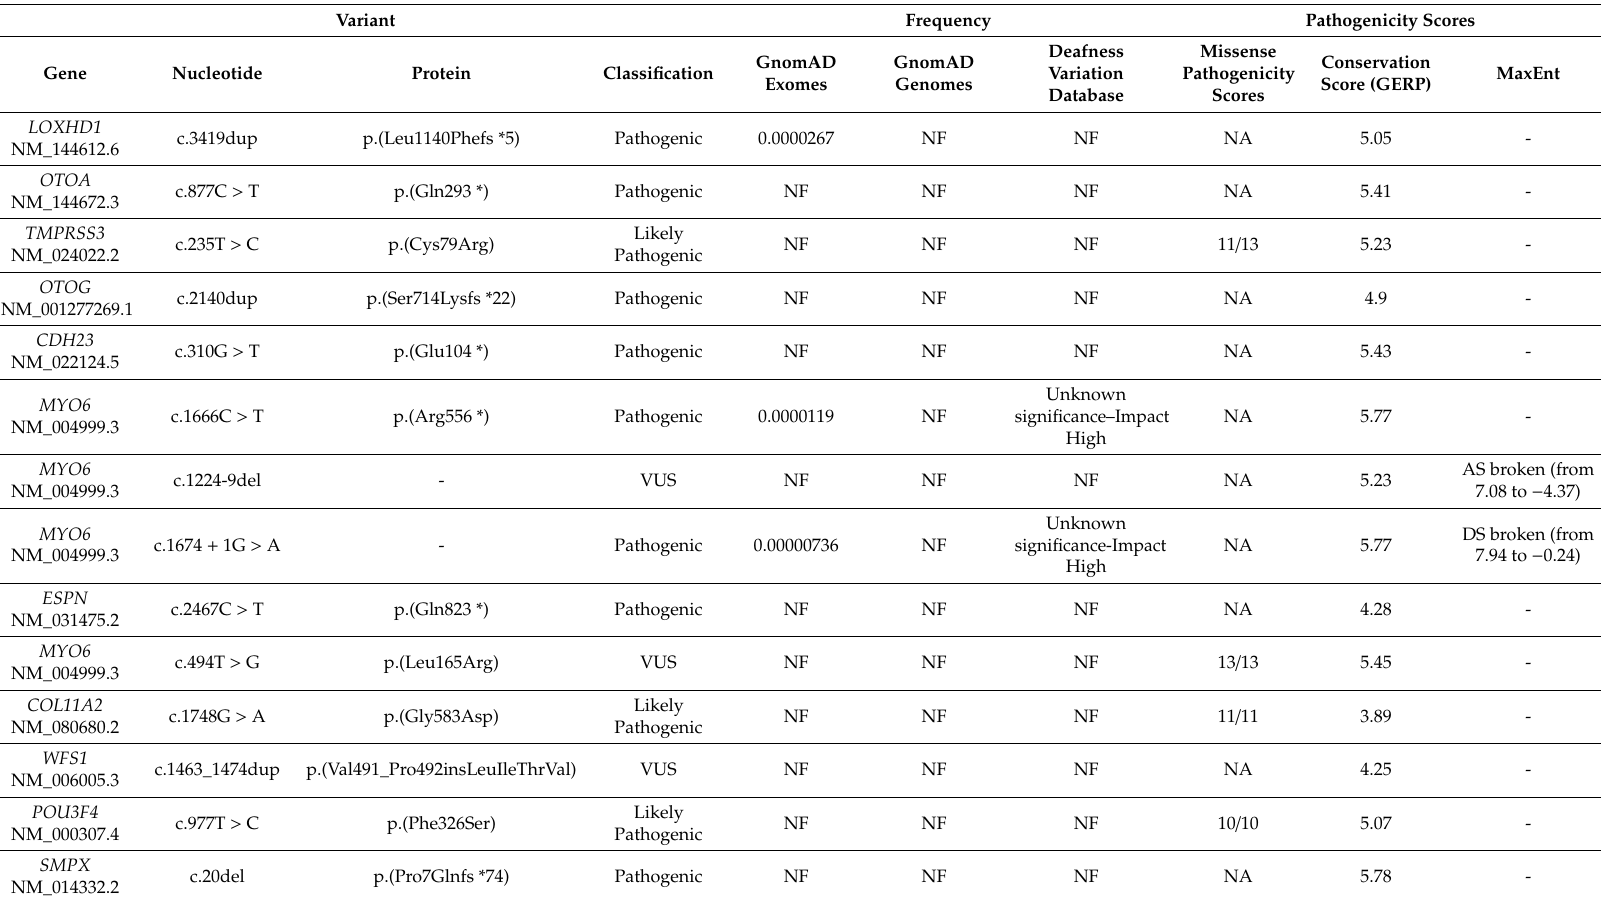
Table 3. Classification of Novel Variants Identified in this